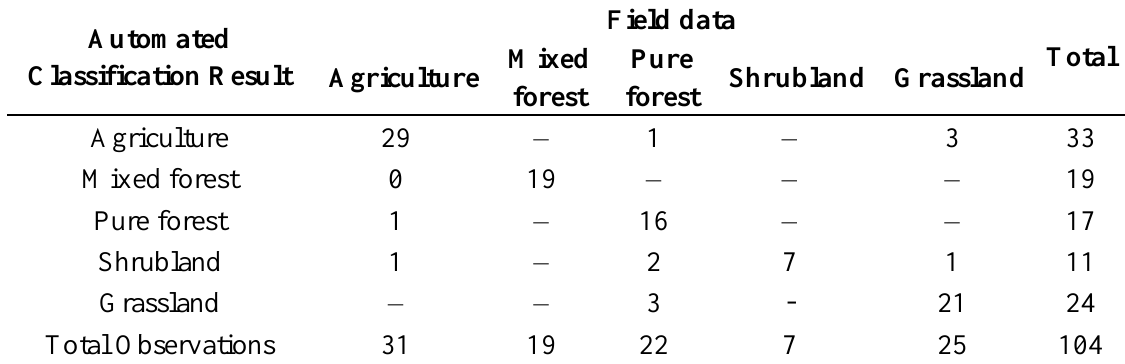
Table 2. Error matrix of field data versus ETM+ 2003 showing classification accuracy of the true land cover (LC).